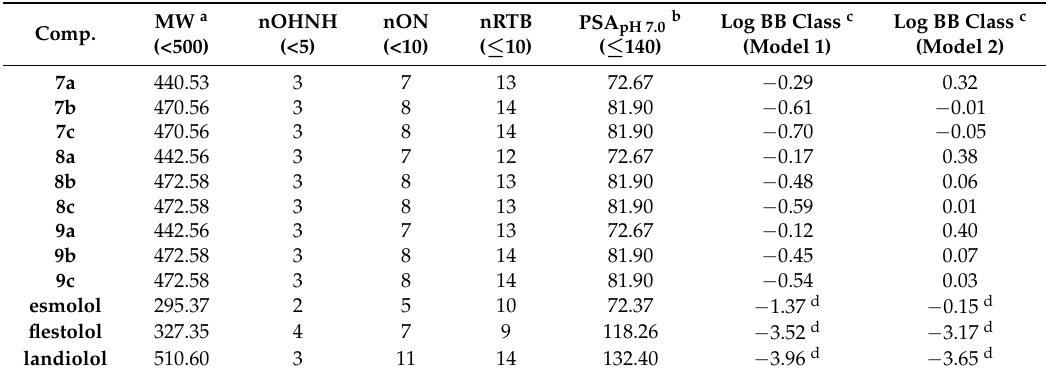
Table 3. Calculated parameters related to toxicity and absorption, distribution, metabolism, and excretion